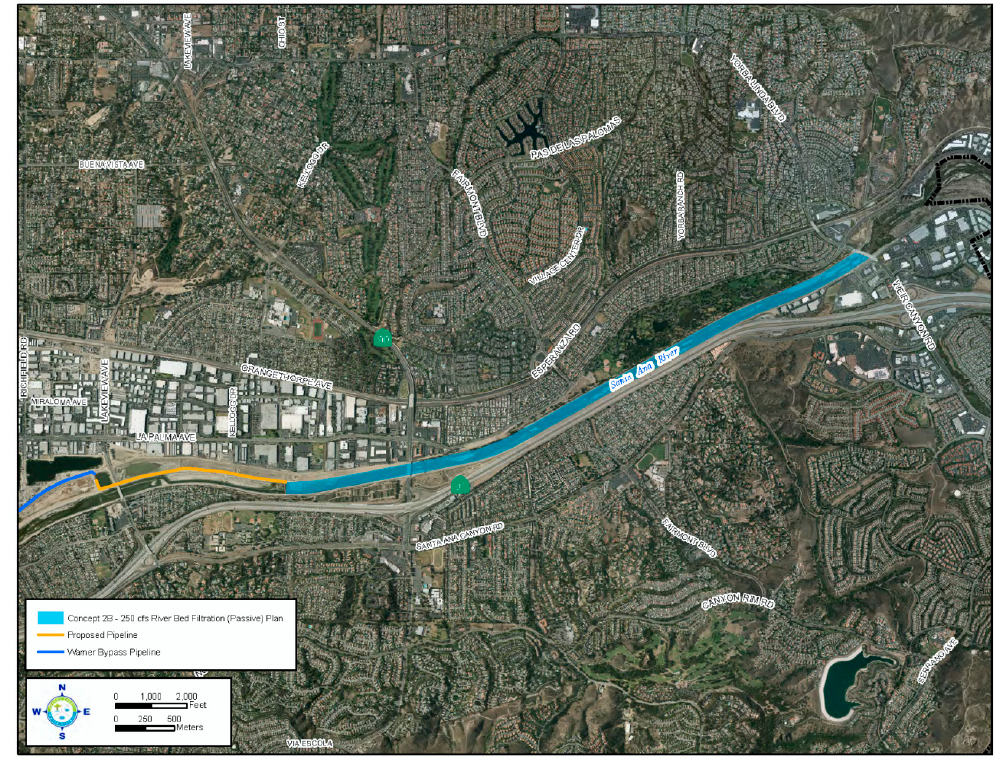
Figure 8. Potential Location of Riverbed Filtration System (RFS) in Santa Ana River Channel.